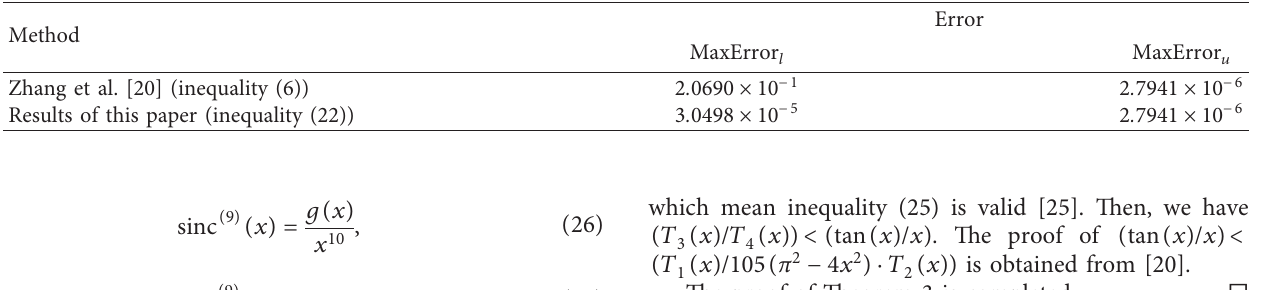
Table 4: Comparison of the maximum errors between tan ( x ) and its bounds for different